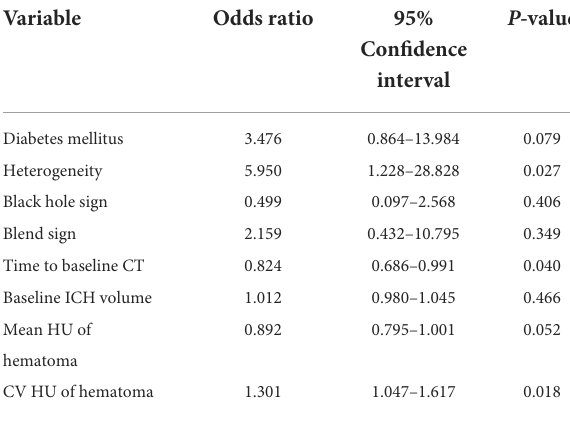
TABLE 3 Multivariate analysis of predictors for early hematoma growth.